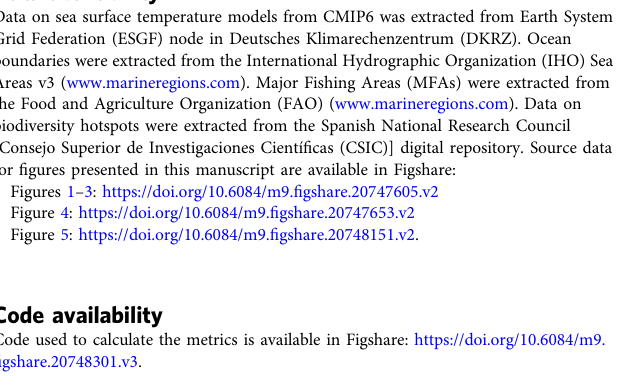
Figure 5: https://doi.org/10.6084/m9. fi gshare.20748151.v2.